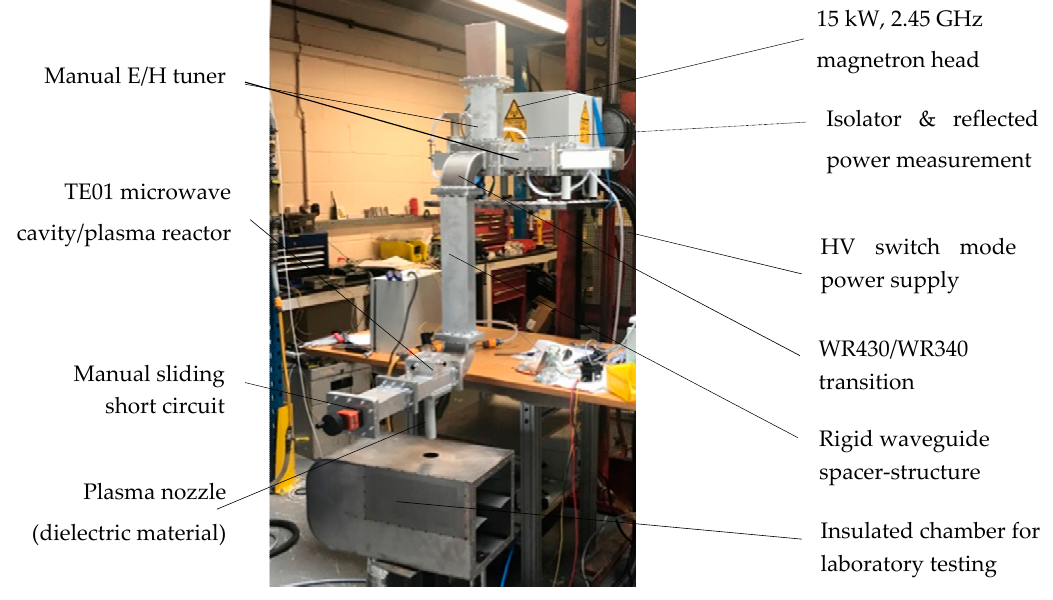
Figure 1. Laboratory setup of the microwave plasma rig.